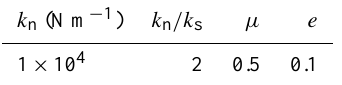
Table 2. Mechanical parameters used in the simulations for the co- hesive law. k n : bond normal stiffness; k s : bond shear stiffness. σ t : macroscopic tensile strength; σ s : macroscopic shear